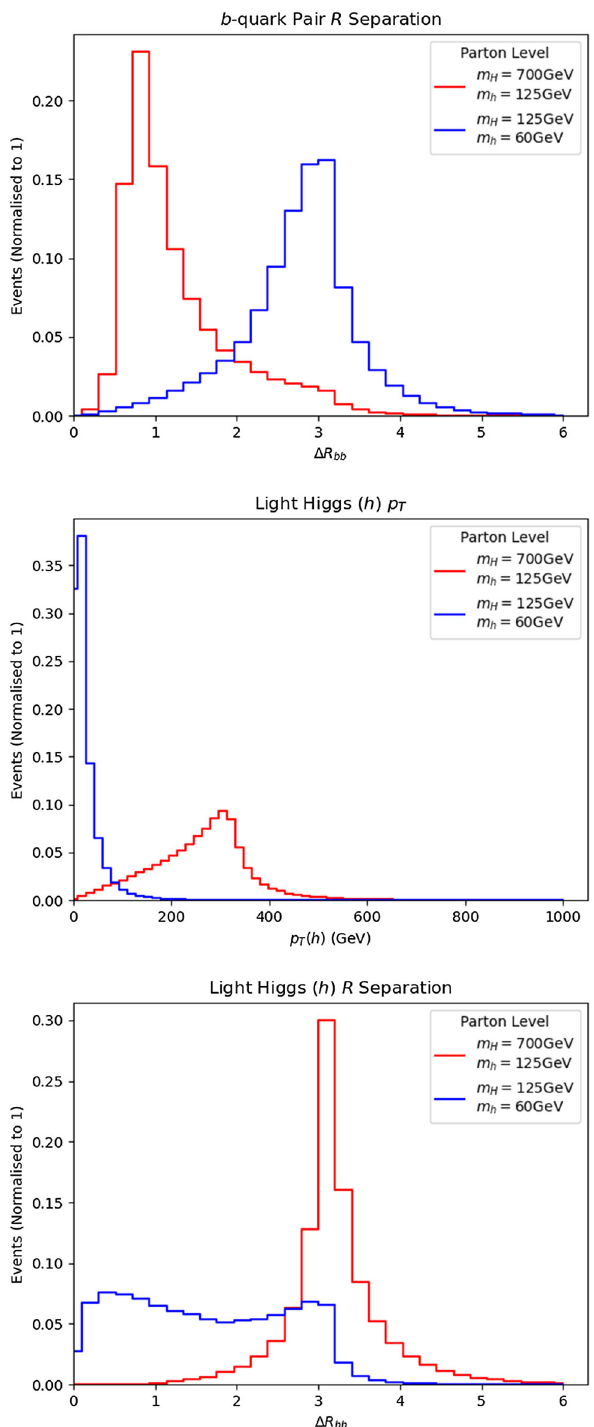
Fig. 6 Upper panel: the Δ R distribution between the two b -partons originating from the same h . Middle panel: the p T distribution of the light Higgs boson h originating from H decay. Lower panel: the Δ R distribution between the two h states originating from the H decay. No (parton level) cuts have been enforced